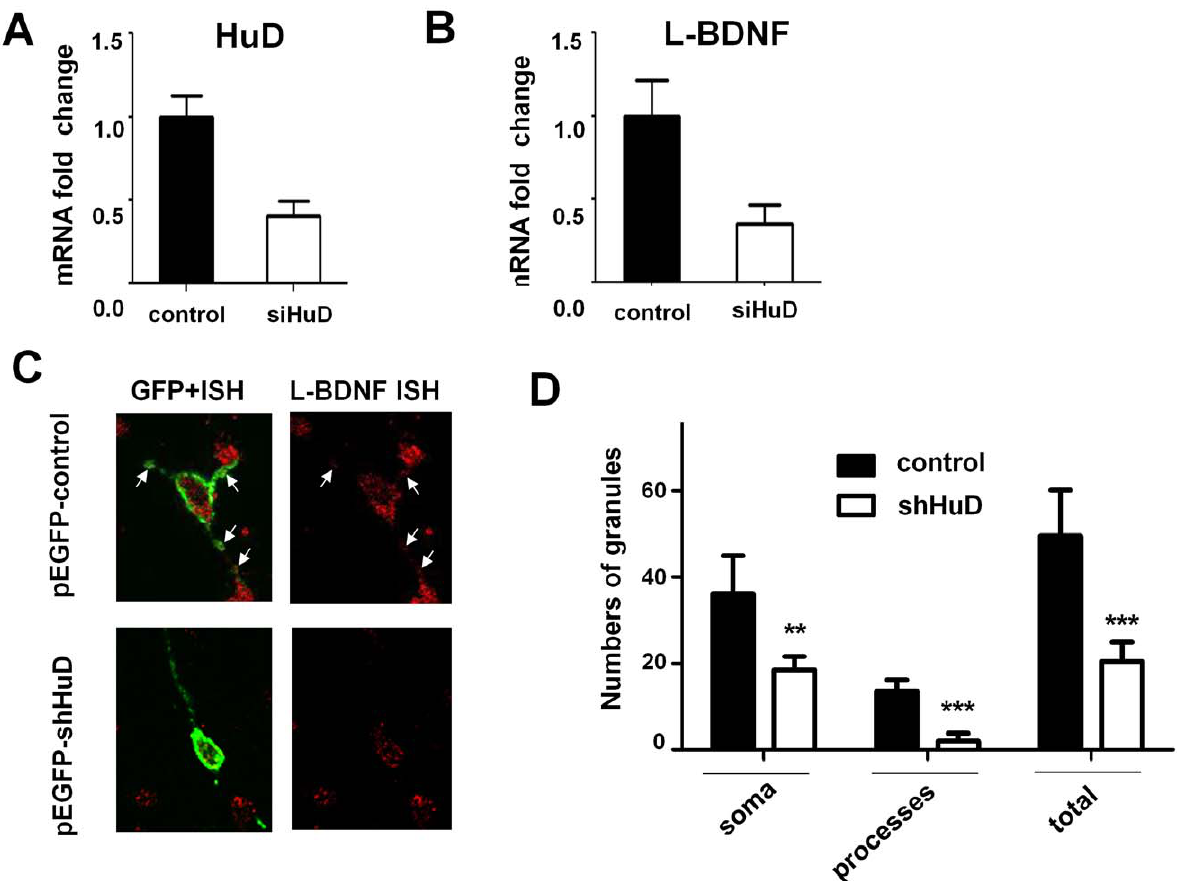
Figure 4. HuD knockdown reduced the levels of endogenous BDNF long 3 9 UTR mRNA. (A) siRNA knockdown of HuD in transfected CAD cells measured by qRT-PCR using a HuD-specific primer flanking the target site by the siRNA. (B) Reduction of endogenous BDNF long 3 9 UTR mRNA in CAD cells measured by qRT-PCR as a result of HuD knockdown. For (A) and (B), results were derived from 3 independent experiments (n=3), * indicates P , 0.05. (C) Representative confocal images of L-BDNF FISH (red) in E17 hippocampal neurons transfected with either pEGFP control vector or pEGFP-shHuD plasmid. The transfected cells was marked by the green fluorescence and the number of FISH grains were counted in the cell bodies and processes (n=6 for each condition) and graphically displayed in (D). Arrows mark the FISH grains in the processes. Note that the number of ISH grains in the shHuD- treated cells decreased throughout the soma and neurite relative to control GFP-vector treated cells.